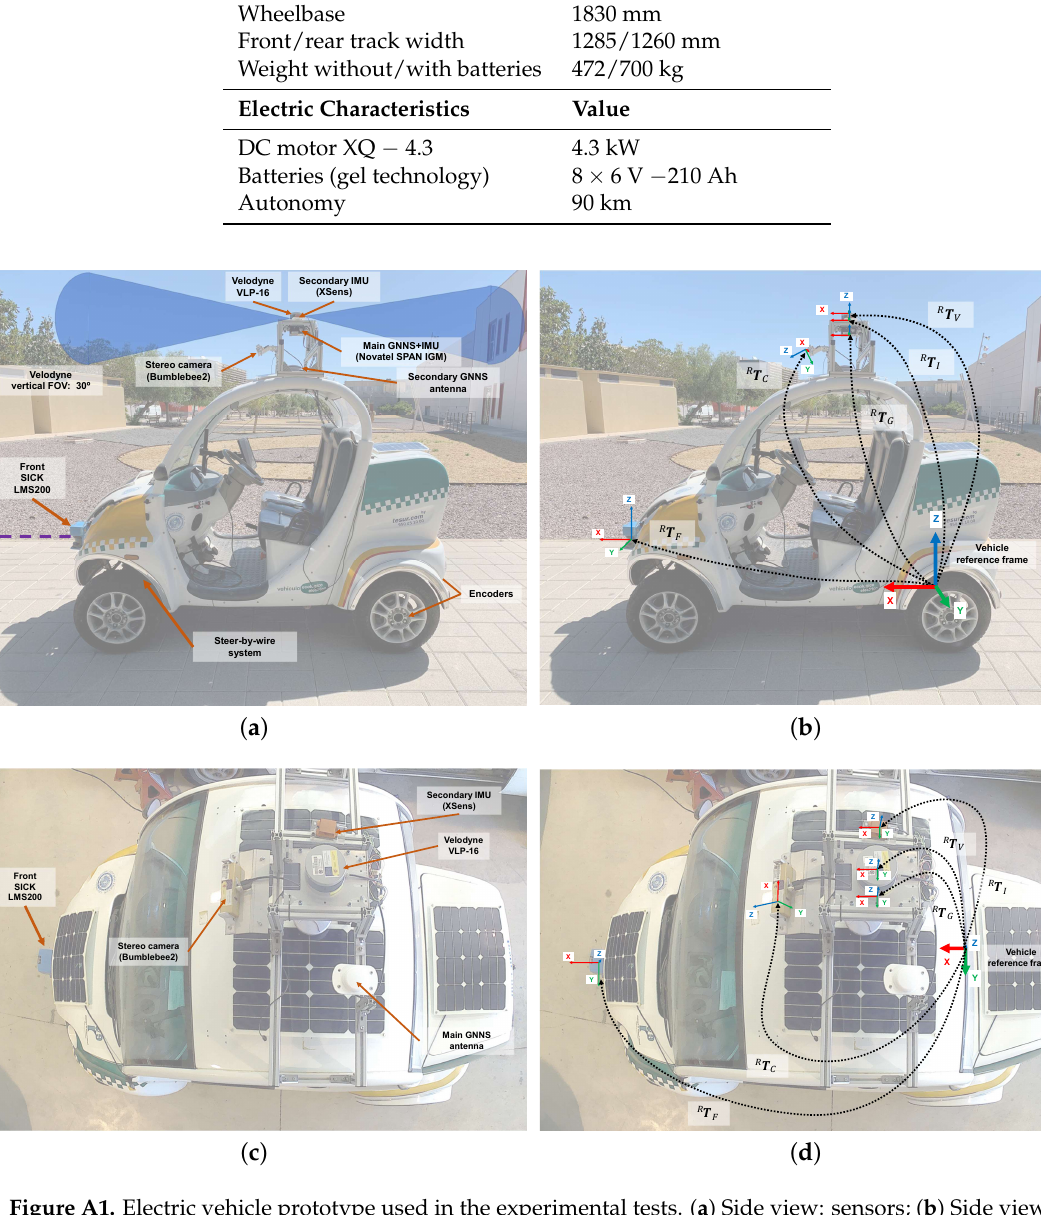
Figure A1. Electric vehicle prototype used in the experimental tests. ( a ) Side view: sensors; ( b ) Side view: frames; ( c ) Top view: sensors; ( d ) Top view: